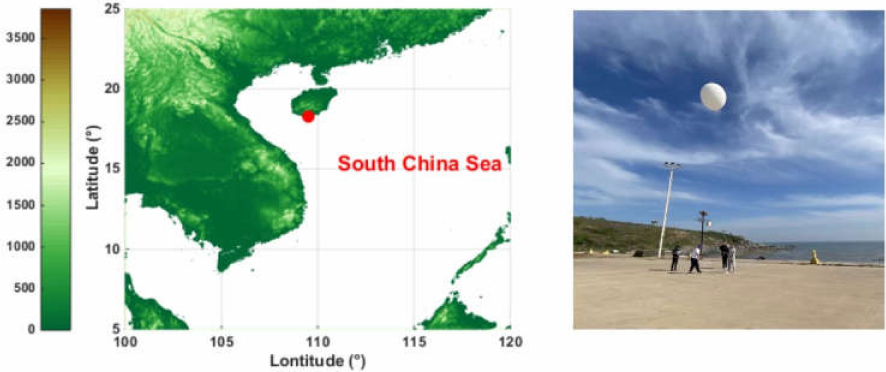
Figure 1. Location of experiment site ( left ) and experimental scenario picture of balloon-borne micro-thermometer ( right